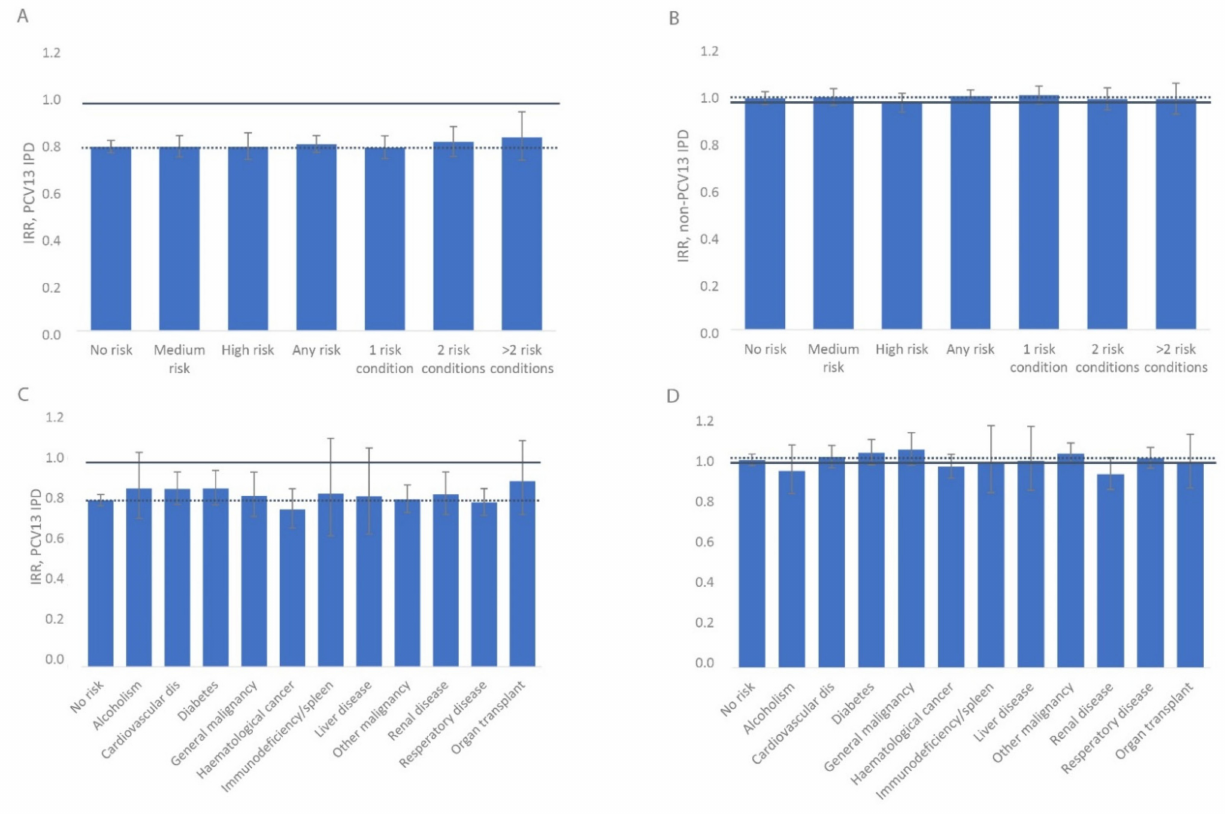
Figure 3. Average annual change in IPD incidence rate, by medical risk in the population aged 5 years or older, Norway, 2011 to 2017. ( A ) PCV13 IPD, ( B ) non-PCV13 IPD, ( C ) PCV13 IPD, ( D ) non-PCV13 IPD. PCV13 serotypes are 4, 6B, 9V, 14, 18C, 19F, 23F, 1, 3, 5, 6A, 7F and 19A; non-PCV13 serotypes are all serotypes not included in PCV13. The solid line indicates 1 for significance. The stippled line reflects the level of the no risk